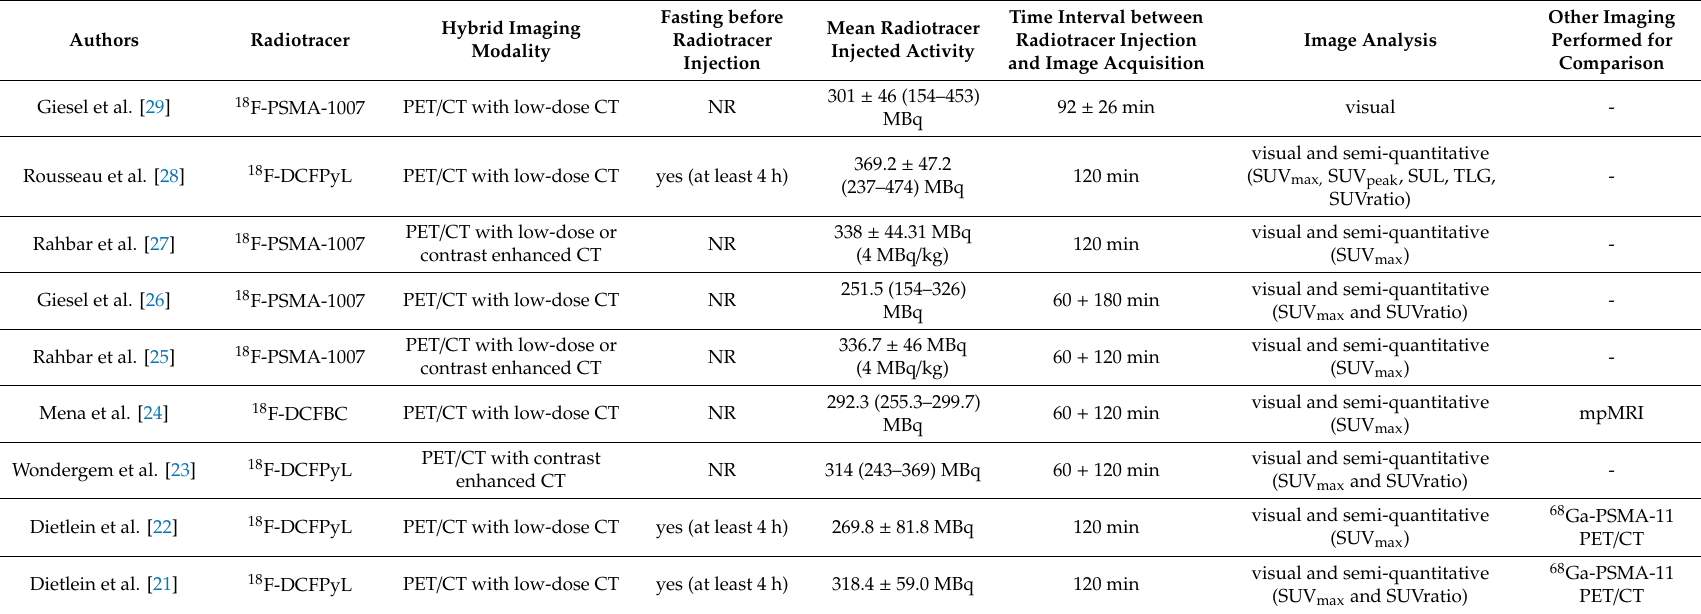
Table 2. Technical aspects of 18 F-PSMA PET / CT in the included